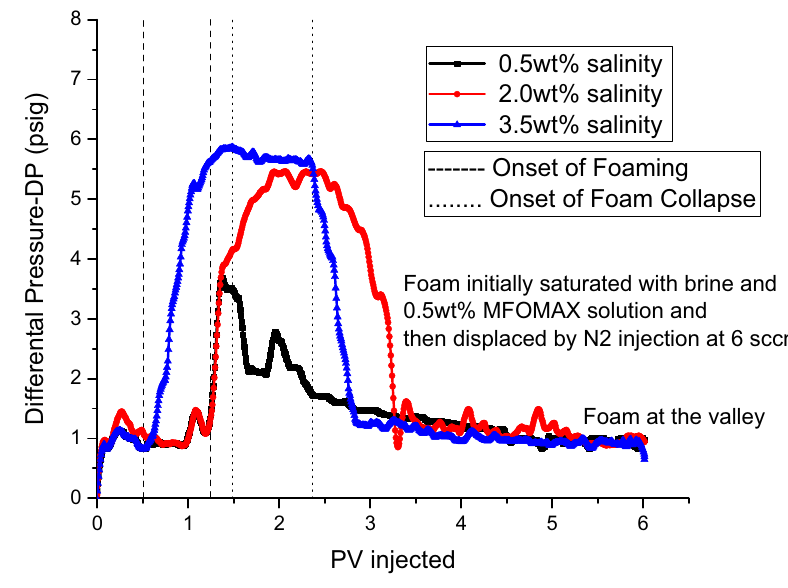
Fig. 3 Determination of salinity effect by using the unsteady- state surfactant drainage by gas flooding in the sandpack